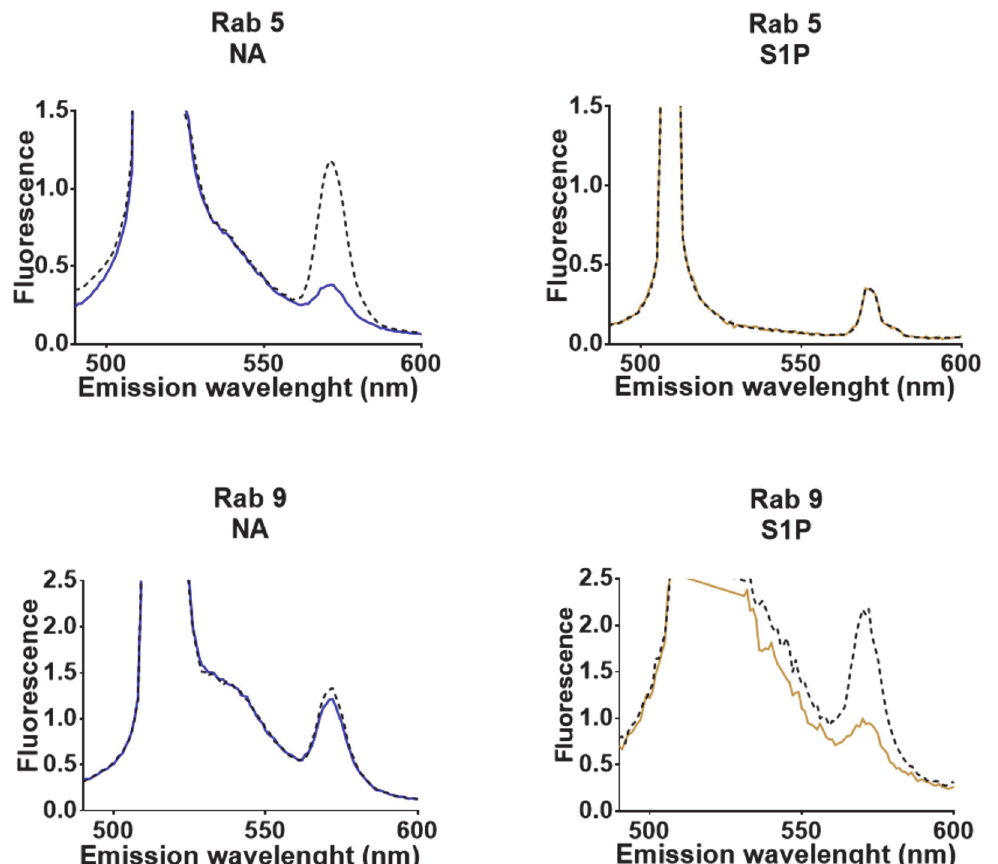
Fig 12. Representative emission spectra obtained from cells coexpressing Ds-Red-tagged α 1B-adrenergic receptors and EGFP-tagged Rab proteins 5 or 9. The emission spectrum was captured at time zero (baseline, continuous lines), then cells were incubated for 15 min with 10 μ M noradrenaline (NA, blue lines) or with 1 μ M sphingosine 1-phosphate (S1P, brown lines) and then, the emission spectrum was captured again (black dotted lines).